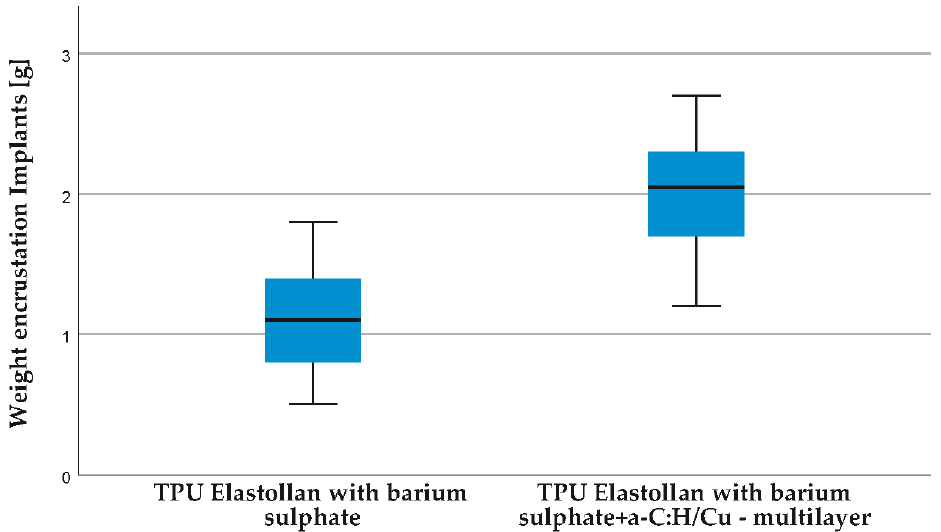
Figure 15. Weights of encrusted implants groups A and B. Indwelling time 21 days. Group A, Elastollan + barium sulphate, median 1.100 g. Group B, Elastollan + barium sulphate + a-C:H/Cu- mulitilayer coating, median 2.050 g. Median is shown with scatter in box and whisker plot. Sample t -test is used ( n = 18, groups p < 0.001, effect size: 0.4 (Hedges’